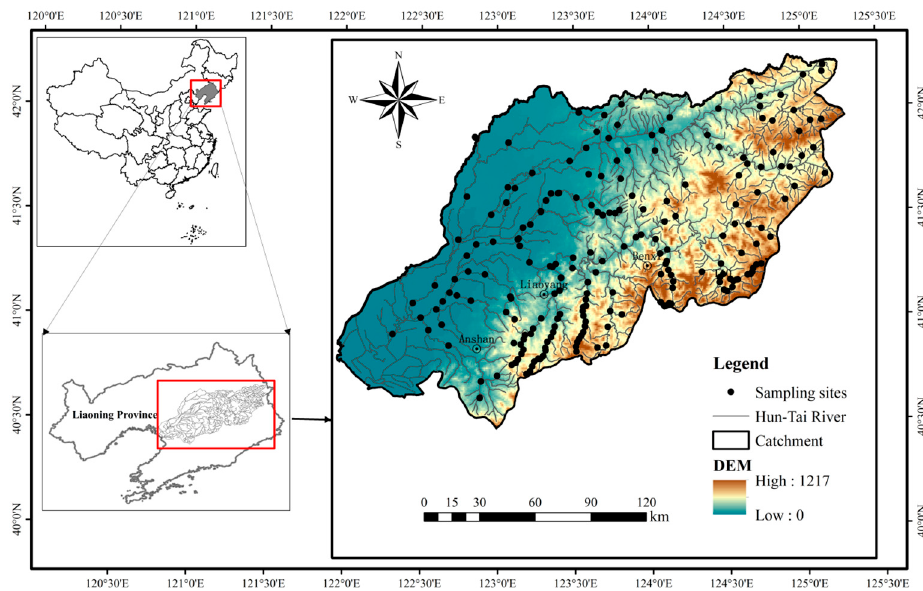
Figure 1. Location of 206 sampling sites in the Huntai River Basin. Sampling was carried out at these sites in August 2009 and July 2010.